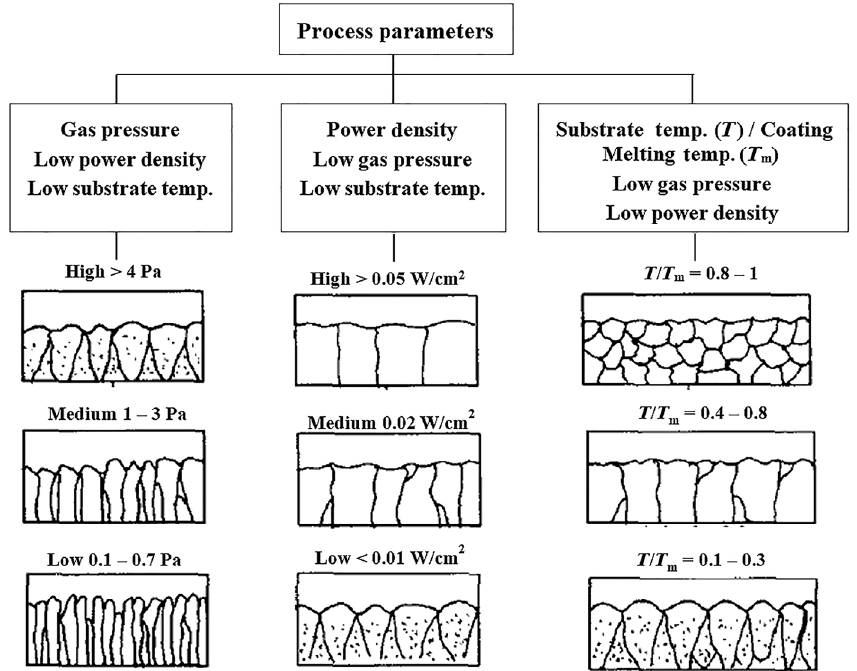
Fig. 8 Effects of ion plating process parameters on coating structure. Reproduced with permission from Ref. [45], © Elsevier,